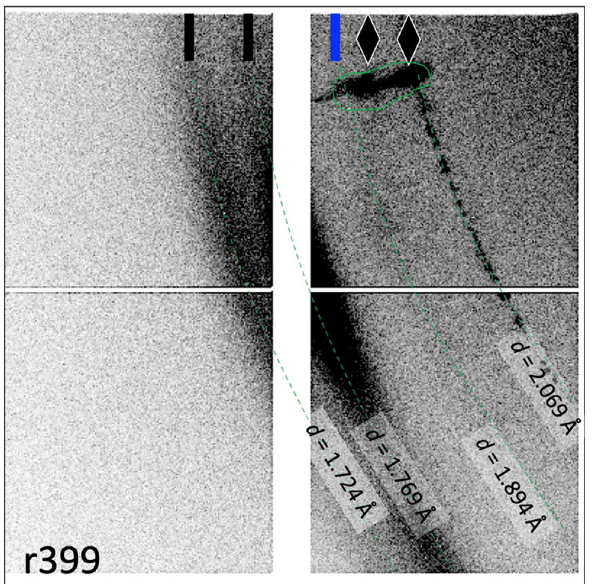
Figure 4. Raw data from Run 399. Repeat of conditions from Run 209, this Run 399 shows diffraction signal from ice XIX with the same doublet feature (black ticks, d -spacings = 1.724 Å, 1.769 Å), the ablator diamond (blue tick, d -spacing = 1.894 Å), the VISAR window diamond (black diamonds, d -spacing = 2.069 Å and elongated feature at the top of the image which could be due to a small volume fraction of the single crystal responding to the stress distribution from compressive wave interactions). Light green lines are guides for the eye or to outline